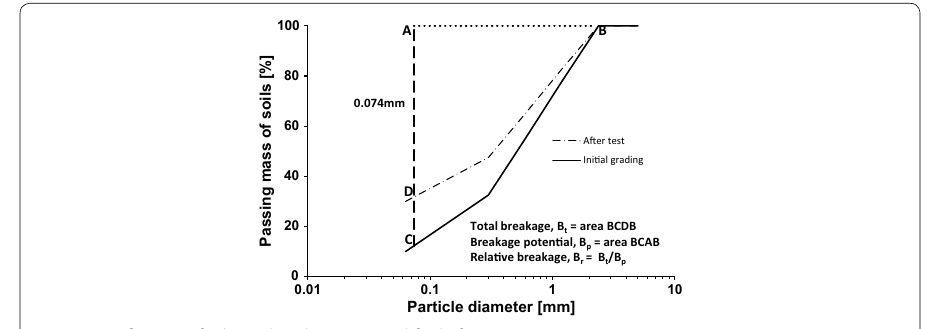
Fig. 10 Definition of relative breakage B r (Modified after